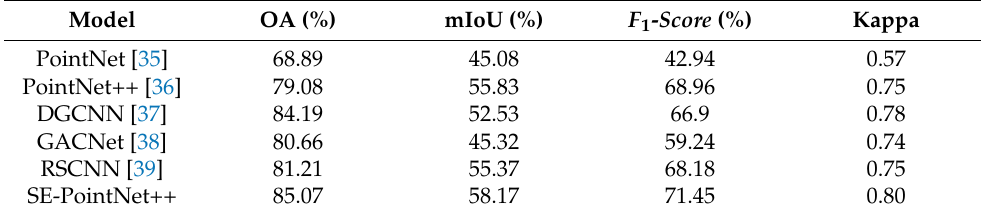
Table 7. Point cloud classification results obtained by different